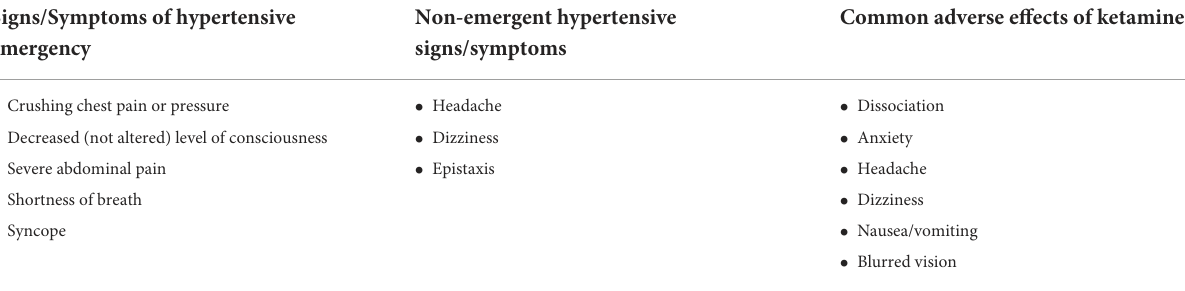
TABLE 1 Signs or symptoms of hypertensive emergencies, hypertension, and common adverse effects of ketamine. Signs/Symptoms of